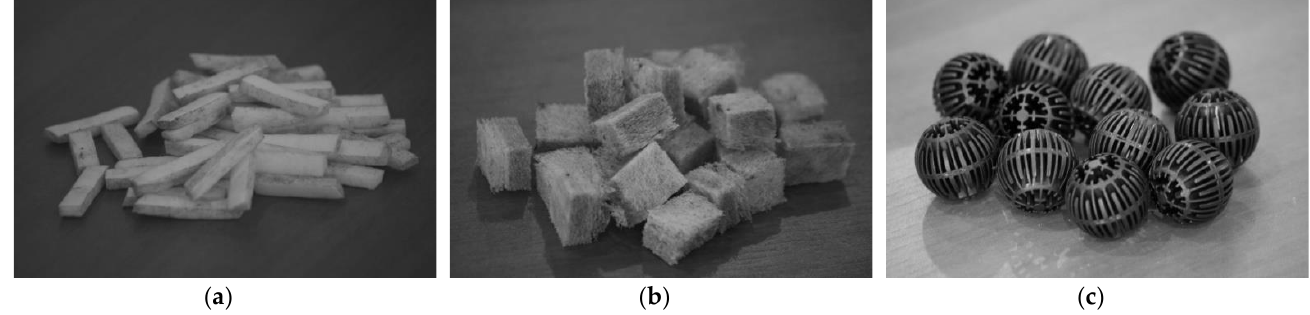
Figure 5. Floating carriers used in the research: ( a ) Polystyrene; ( b ) Polyvom; ( c ) Bioballs.